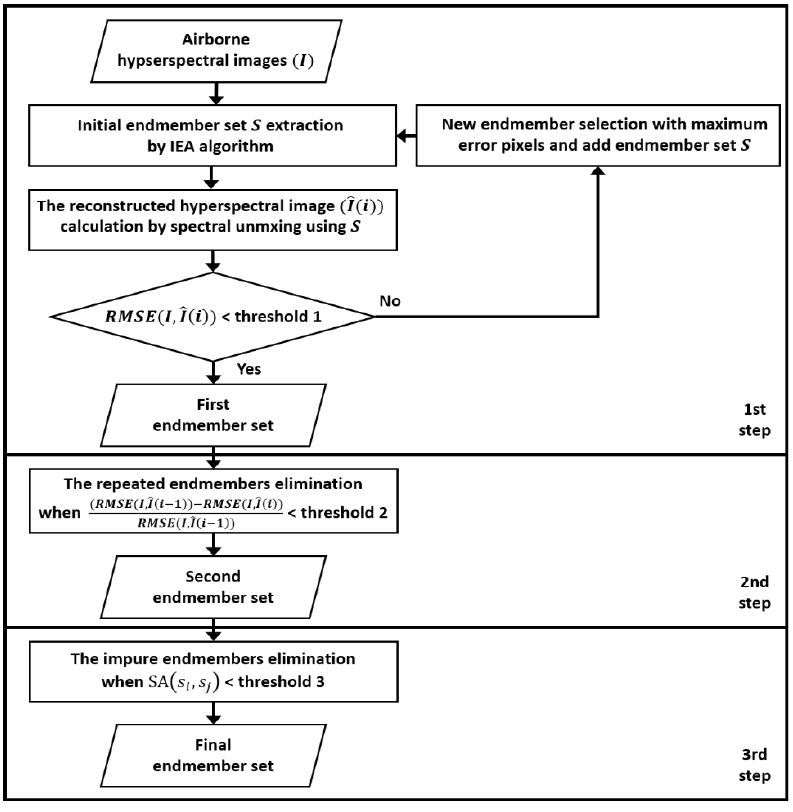
Figure 2. Flow chart of the proposed